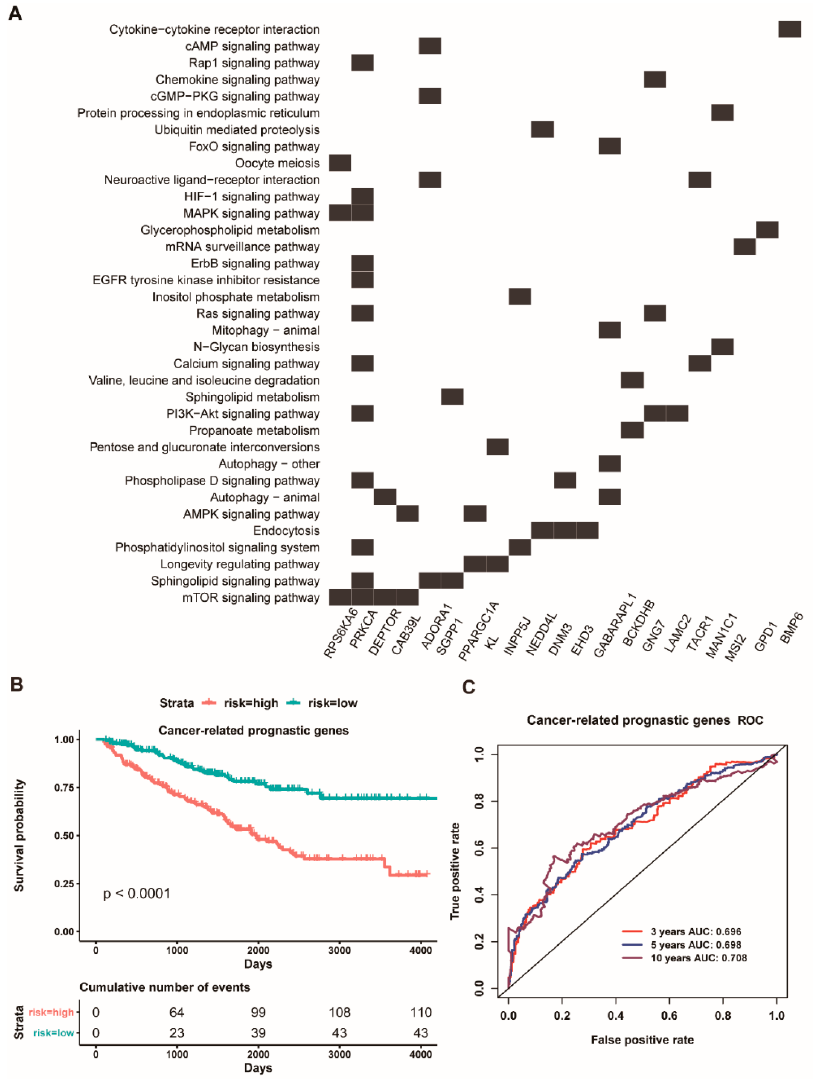
Figure 5. The heat map of down-regulated targets of three up-regulated miRNAs involve in cancer-related signaling pathway and the prognostic model of the five-gene signature. ( A ): The heat map of these down-regulated targets regulated by has-miR-3613-5p, has-miR-223-3p, and has-miR-365b-3p involved in cancer-related signaling pathways; ( B ): Overall survival curves for high-risk and low-risk groups based on the prognostic model of a five-gene signature; ( C ): ROC curves for high and low risk from the prognostic model of a five-gene signature.